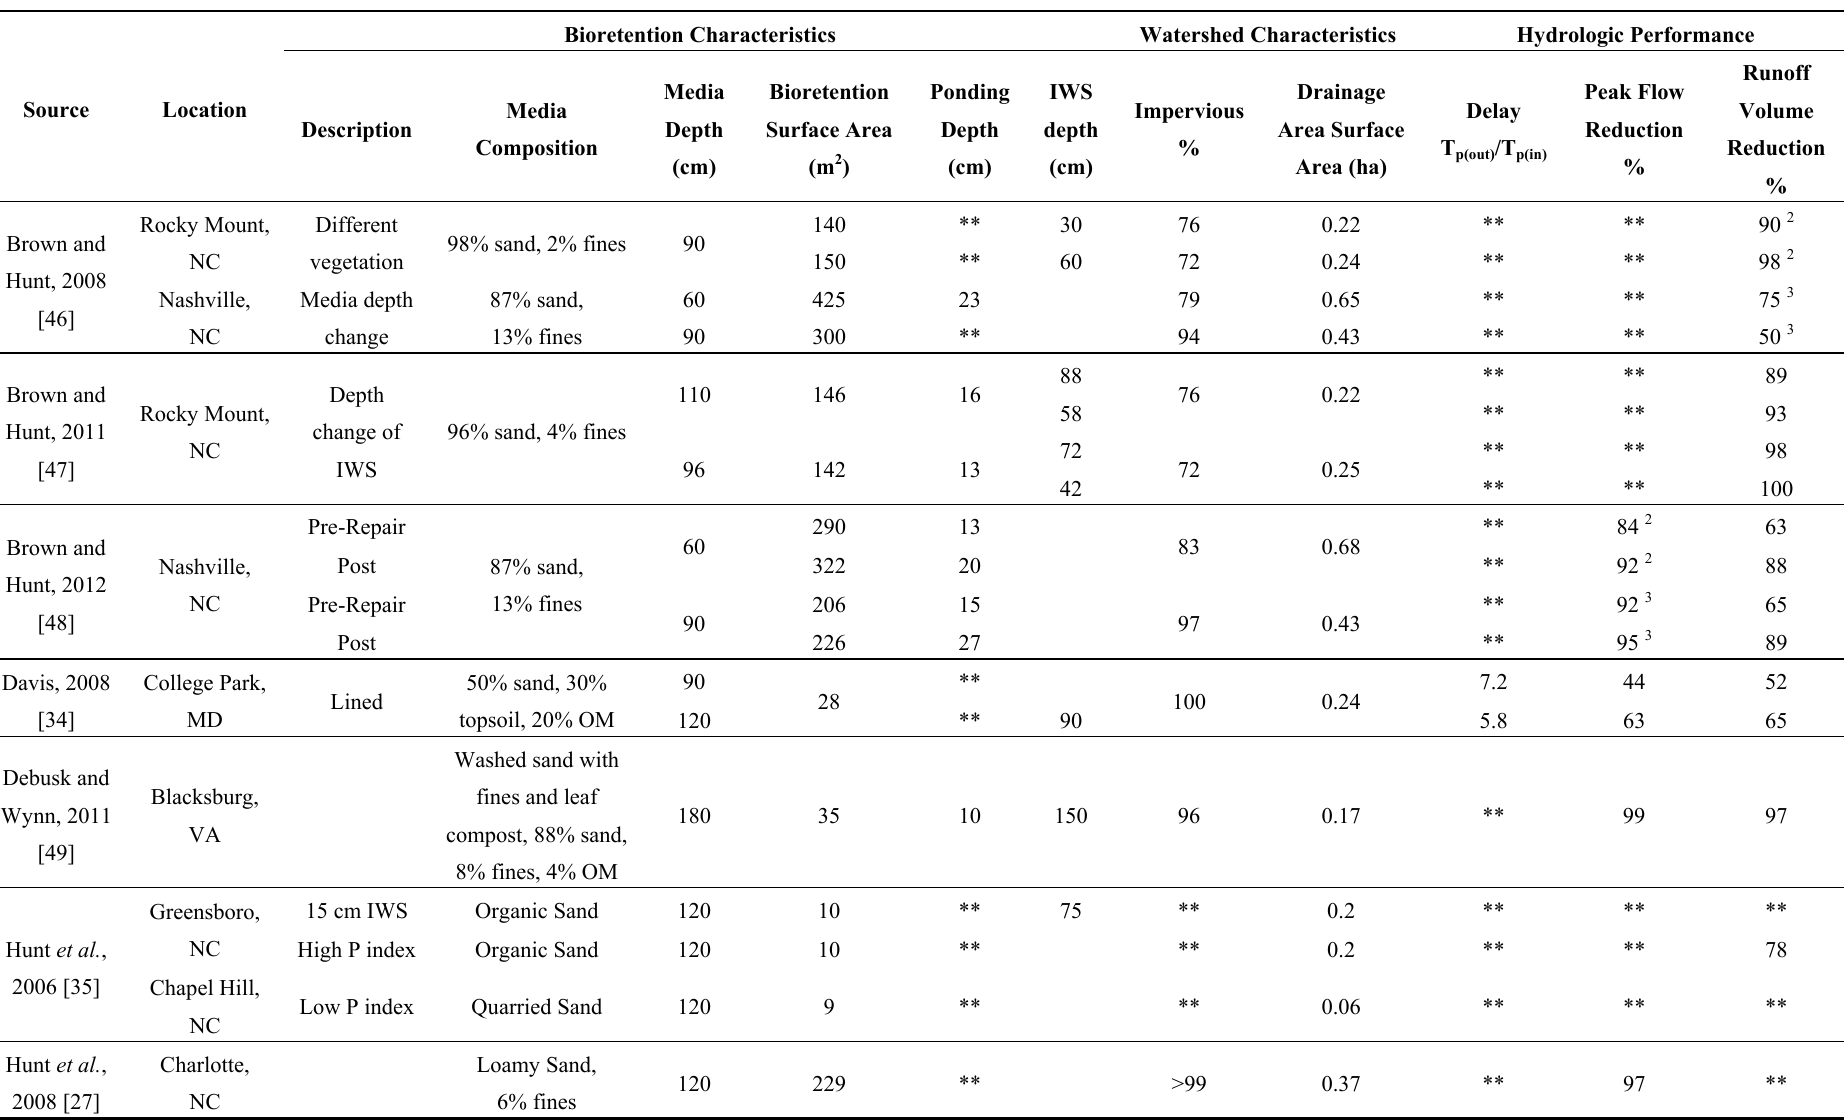
Table 1. Summary of bioretention field studies, hydrologic